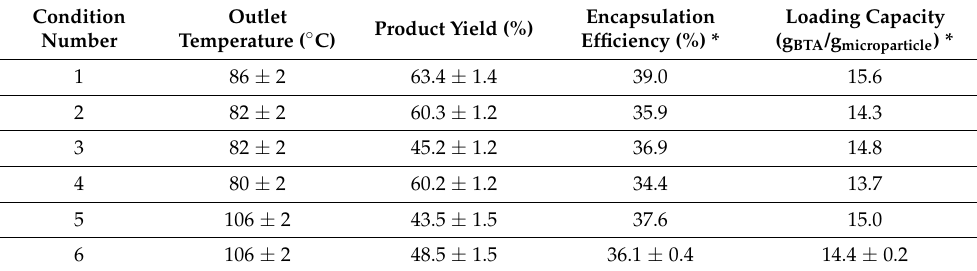
Table 4. Effect of the different spray drying conditions on the product yield and loading capacity of the